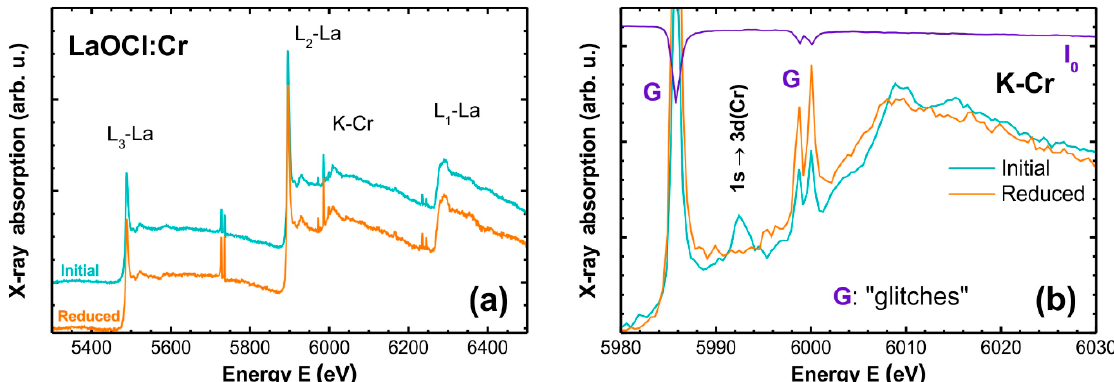
Figure 7. Experimental XANES spectra recorded in the range of the La L 1,2,3 ‐ edges and Cr K ‐ edge for 2% Cr LaOCl samples before and after annealing in reducing atmosphere. The I 0 signal measured by the ionization chamber located before the sample is shown at the top in ( a ). Several “glitches” are observed and labelled with the letter “G” in ( b ).